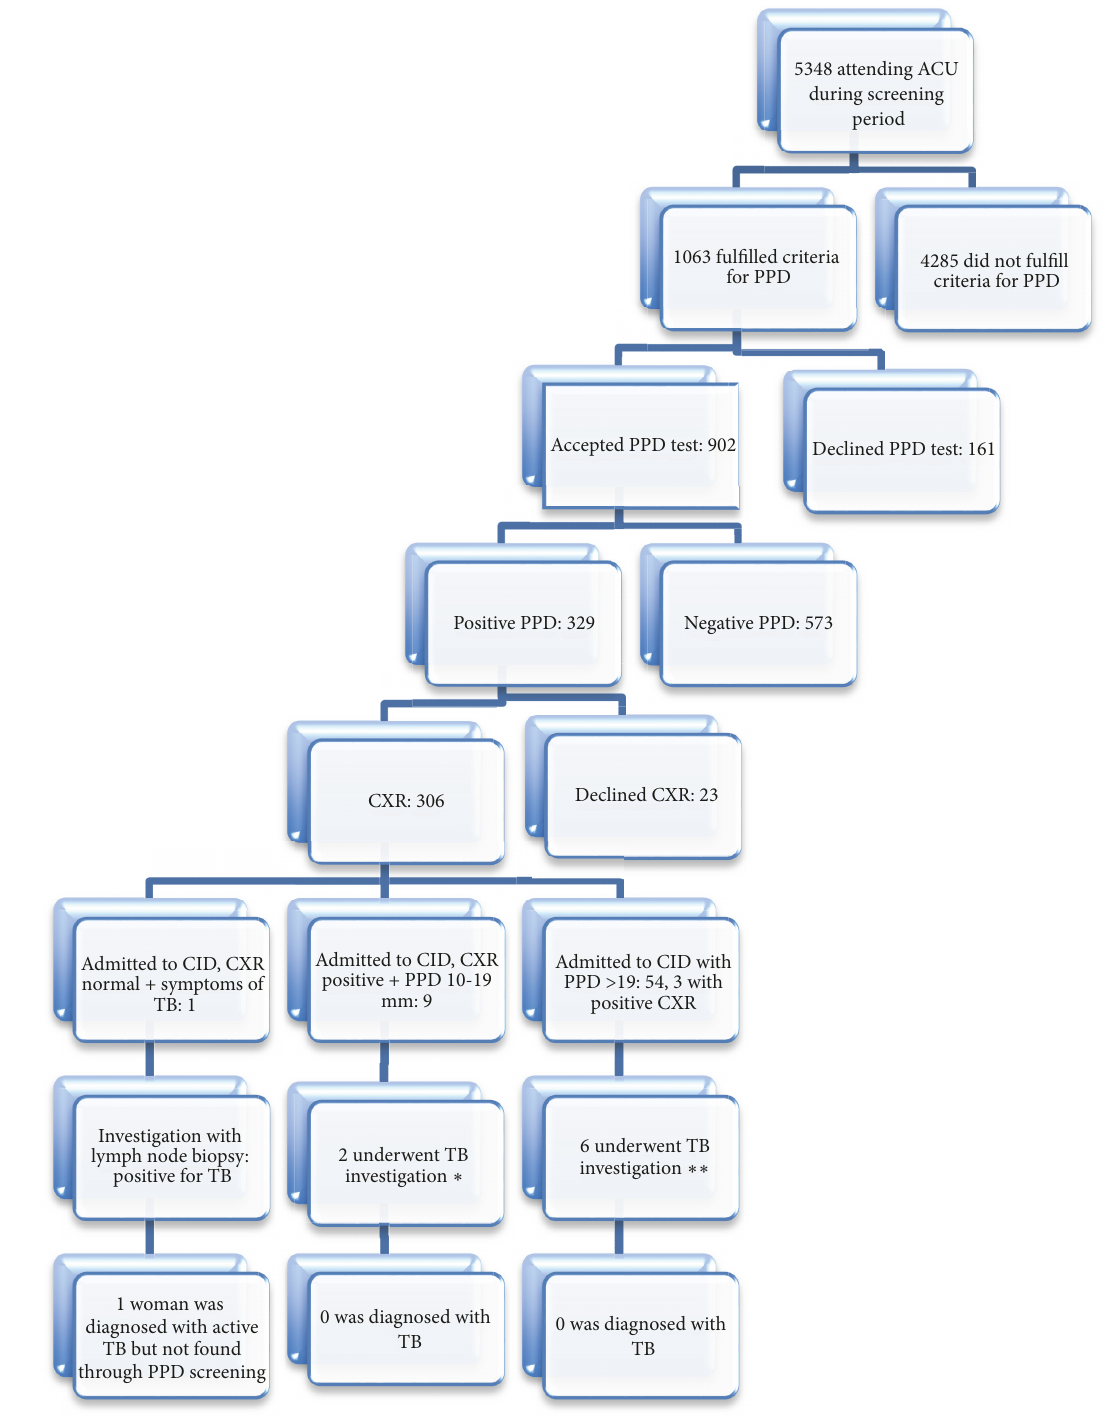
Figure 1: Flowchart describing TST of pregnant women (using PPD) at Bor˚as ACU during November 2008–June 2012. ∗ represents 1 CT scan of thorax and 1 IGRA negative. ∗∗ represents 1 IGRA positive, 3 urinary TB culture, 1 urinary TB culture + culture from nasopharynx, and 1 CT scan of